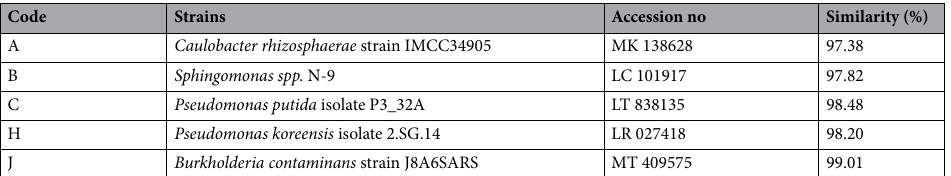
Table 4. The molecular identification of the isolated nitrogen fixing bacteria in soils supplemented with phosphorus and lime, soils rich in phosphorus and control soils collected at Ukulinga farm, KwaZulu-Natal.